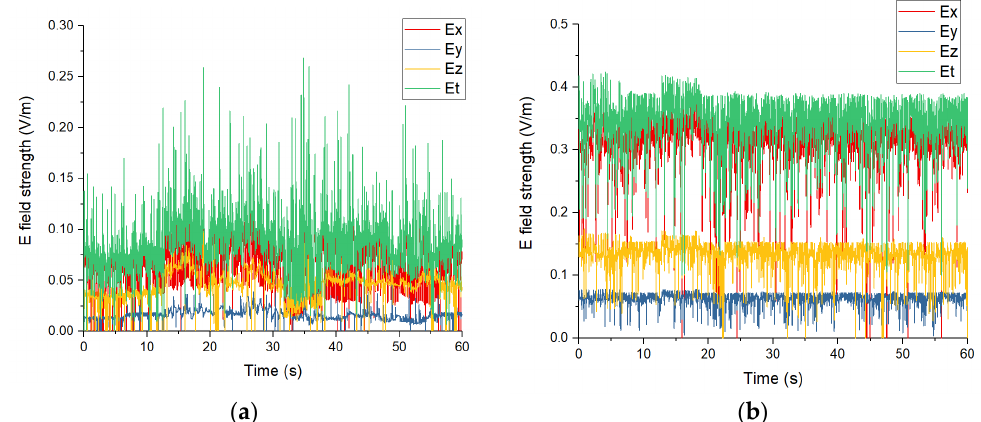
Figure 14. Time evolution of Ex, Ey, Ez, and Etotal for IEEE 802.11ax file download ( a ) and file upload 20 MHz ( b ).